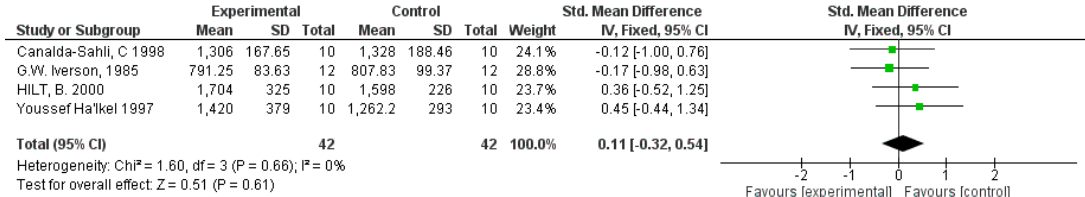
ff ects model of the meta-analysis of the quaternary Figure 4. Forest plot of the fixed effects model of the meta-analysis of the quaternary outcome. Figure 4. Forest plot of the fixed e